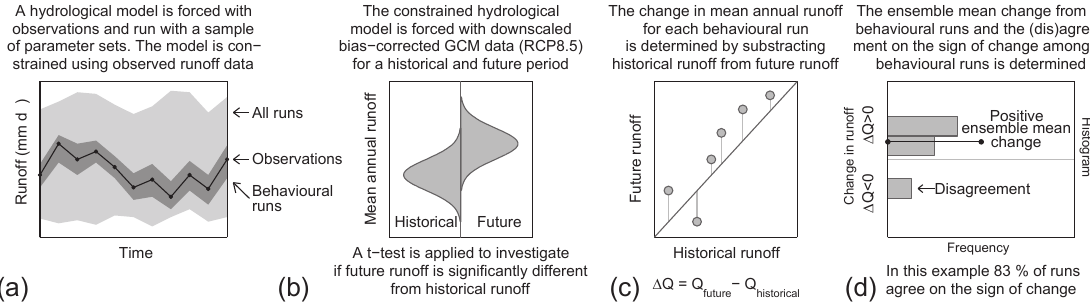
Figure 1. Overview of the conducted procedure, demonstrated for the mean runoff metric. For the discharge timing metric, the same proce- dure was employed. This procedure was repeated for 15 combinations of three hydrologic models and five general circulation models (GCMs) using Representative Concentration Pathway (RCP) 8.5. (a) The hydrologic model was run with a sample of parameter sets for the period 1985–2008. The model was forced with observed Daymet data (Thornton et al., 2012). The size of the parameter sample differed per model, from 1600 to 1900 (see Sect. 2). Behavioural runs were identified based on 23 years of daily observed discharge data. (b) The constrained models, i.e. the behavioural parameter sets, were forced with GCM data for the historical period 1985–2008 and future period 2070–2100. For each run, the mean annual runoff was determined for both periods. (c) The change is defined as the difference in mean annual runoff between the historical and future periods, and is determined per run. (d) Histogram showing the distribution of the change for the different model runs as shown in (c) . The sign of the ensemble mean change is determined, as well as the agreement among the different parameter sets on the sign of the ensemble mean change. The agreement is defined as the percentage of runs that project the same sign of change (positive change = increasing mean annual runoff; negative change = decreasing mean annual runoff) as the ensemble mean change. Finally, the sign of the ensemble mean change is compared for different combinations of hydrologic models and